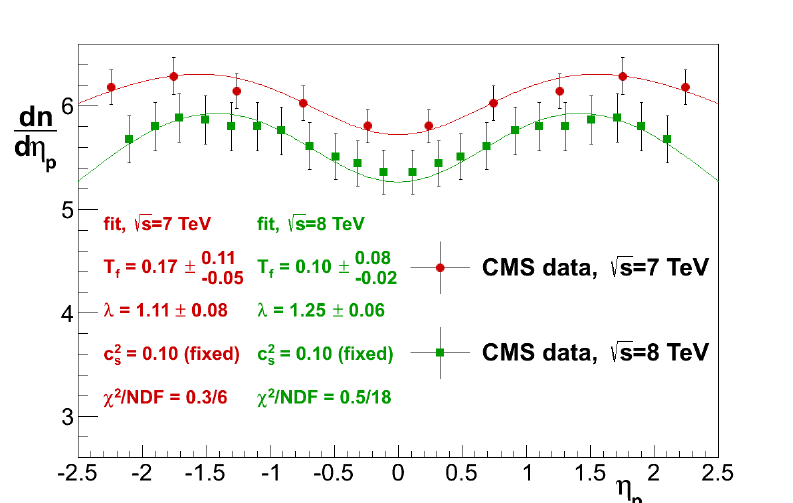
√ s = 7 [72] and 8 TeV [73]